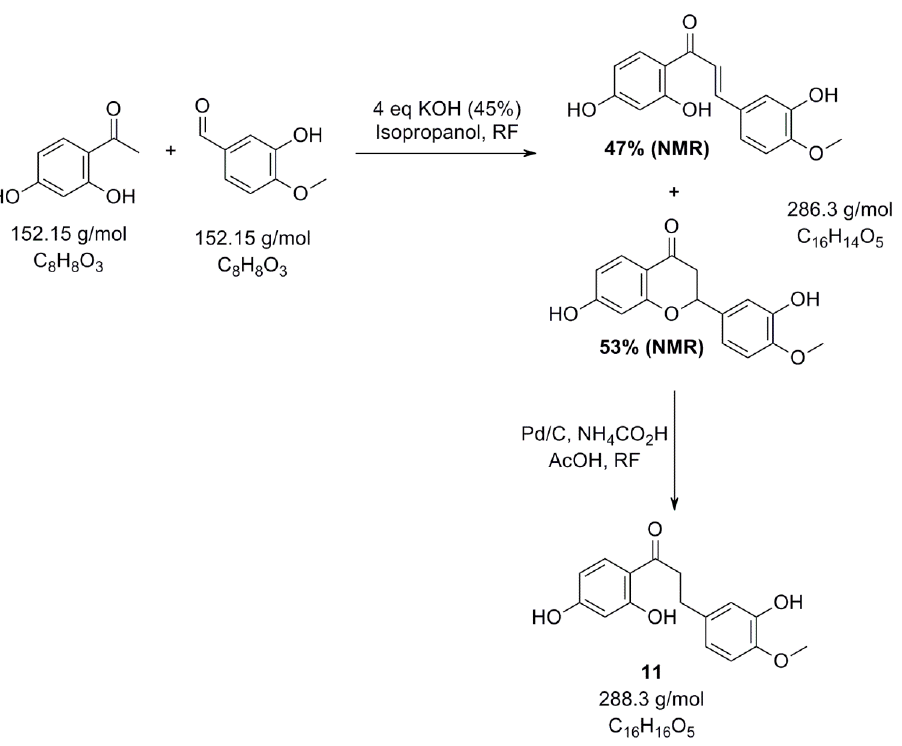
Figure A3. Synthesis of compound 11 .